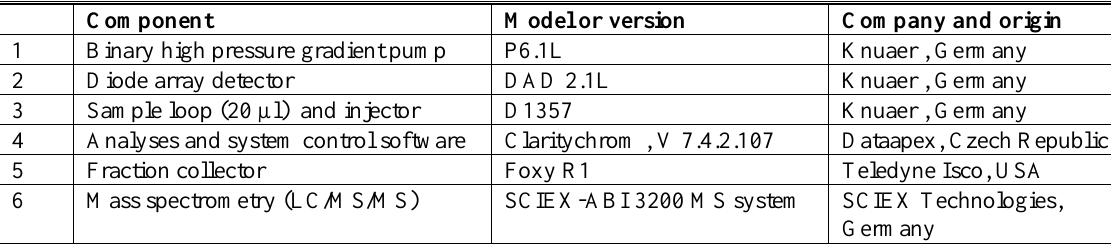
Table 1.Preparative HPLC apparatus